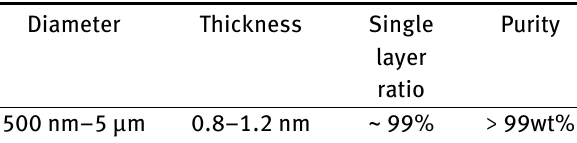
Table 3: Physical properties of